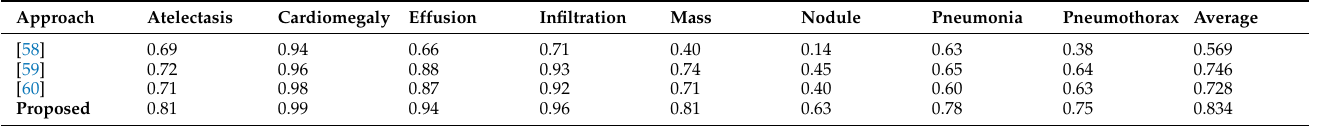
Table 8. Comparative assessment of the presented model with new techniques for the IOU